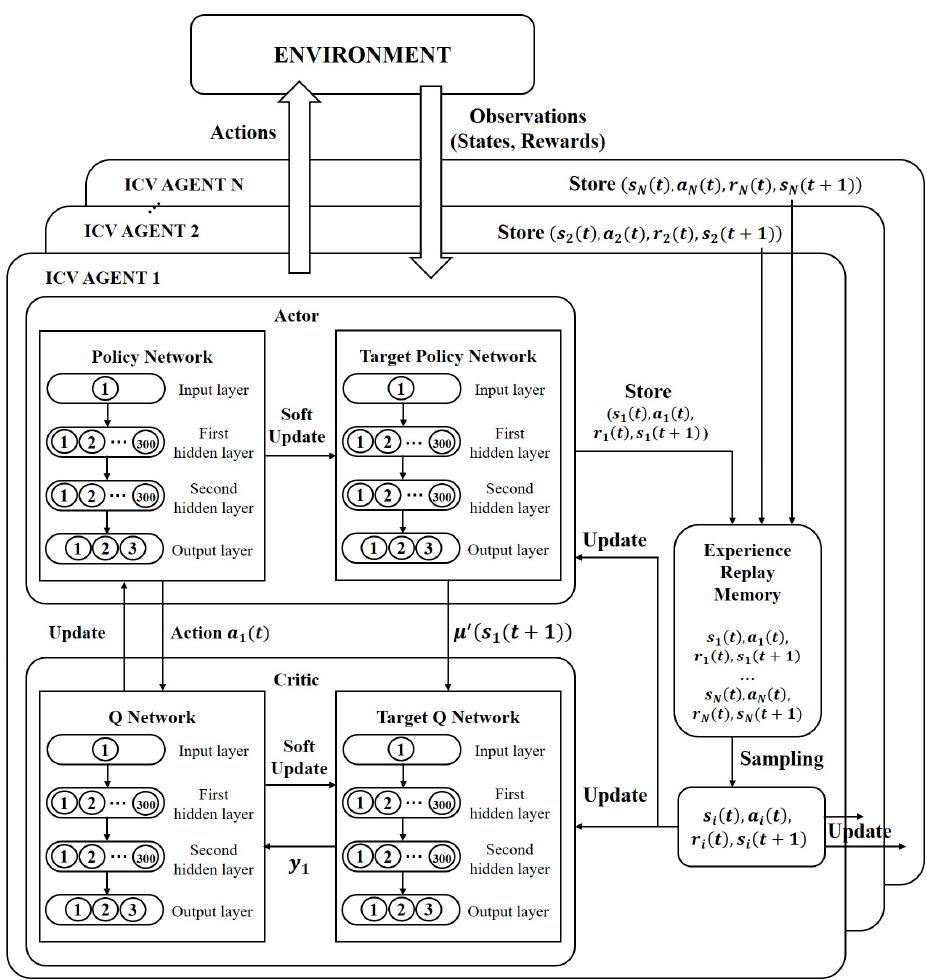
Figure 2. The structure of COPP-DDPG.